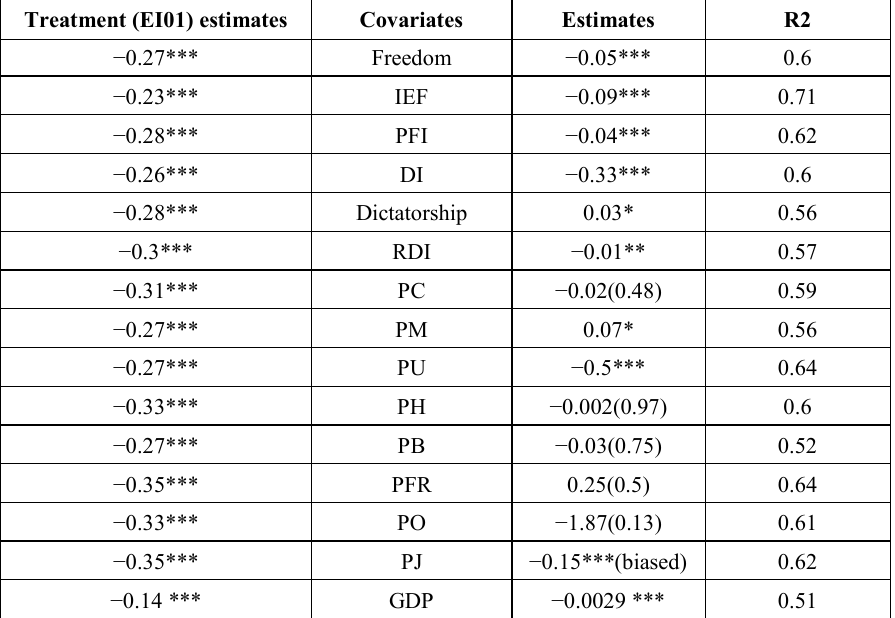
Table 4. PSM Results: Gender Inequality Index as an Outcome, Education Index as a Treatment Treatment (EI01) estimates Covariates Estimates R2 −